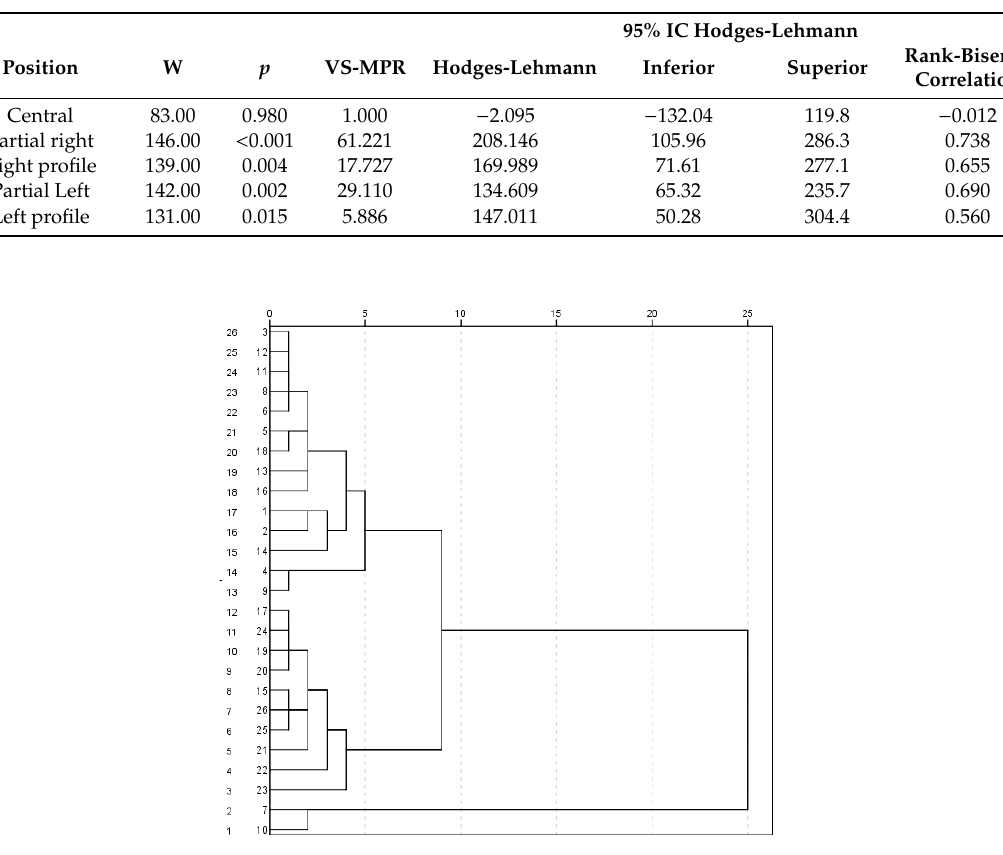
Figure 2. Tree diagram regarding the grouping of participants in a hierarchical cluster analysis.